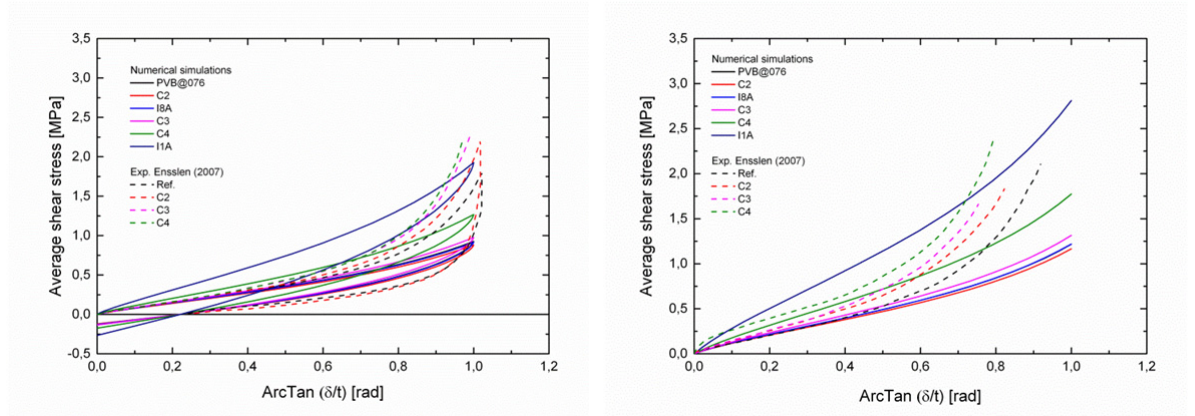
Fig. 1 Test diagrams obtained with the slow tests (left) and with the fast tests (right) by Ensslen (dashed lines) and with the numerical simulations by the authors (solid